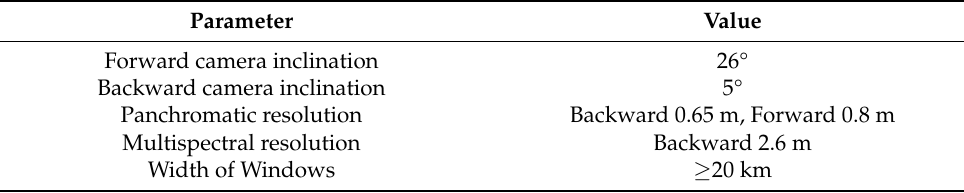
Table 1. Characteristics of the GF-7 satellite stereo images.